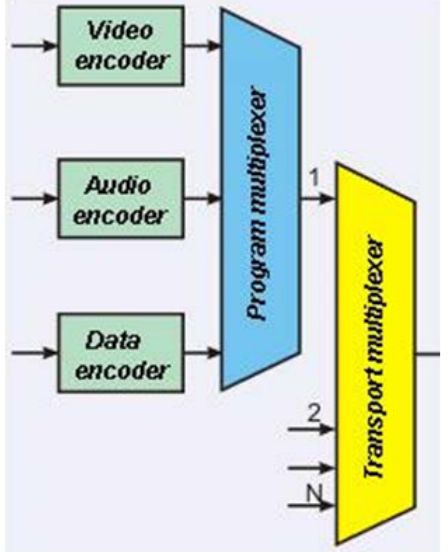
Figure 3. Functional diagram of the encoding and multiplexing station of digital